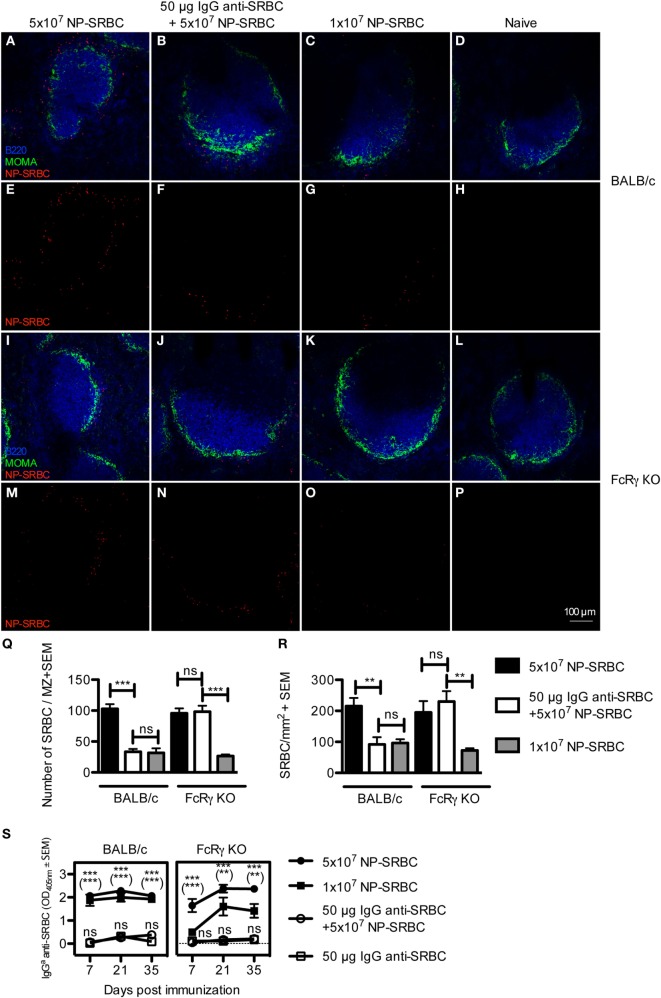
IgG-mediated decrease of the amount of sheep red blood cell (SRBC) in the spleen is dependent on activating FcγRs and does not correlate with suppression. BALB/c and FcRγ KO mice were immunized with 5 × 107 NP-SRBC ± 50 μg IgGb anti-SRBC or 1 × 107 NP-SRBC. Naive mice and mice-receiving IgGb anti-SRBC alone were used as negative controls. Spleens were harvested 10 min after administration of NP-SRBC and processed for analysis by confocal laser scanning microscopy (n = 5/group). (A–P) Visualization of NP-SRBC localization in spleen sections: B220+ B cells (blue), MOMA+ metallophilic macrophages (green), and NP-SRBC (red). Imaging of samples was performed blindly. (Q) Quantification of the number of NP-SRBC per marginal zone. Ten to fifteen randomly selected follicles per spleen per mouse were imaged at 20× magnification. (R) Quantification of the number of NP-SRBC per millimeter square in whole spleen sections. Tile scans of one whole spleen section per mouse were imaged at 10× magnification. (S) The IgG anti-SRBC response was followed in parallel in mice from each group for 7–35 days after immunization (n = 5/group, n = 3 for negative controls). Sera diluted 1:125 were screened for IgGa anti-SRBC in enzyme-linked immunosorbent assay. p-Values for comparisons of mice immunized with IgG anti-SRBC and NP-SRBC vs 5 × 107 NP-SRBC alone are given without parentheses. Comparisons of mice immunized with IgG anti-SRBC and 5 × 107 NP-SRBC vs 1 × 107 NP-SRBC alone are given within parentheses. Data are representative of two (S: BALB/c), one (S: FcRγ KO), or at least three experiments (A–R). ns, p > 0.05; *p < 0.05; **p < 0.01; ***p < 0.001.